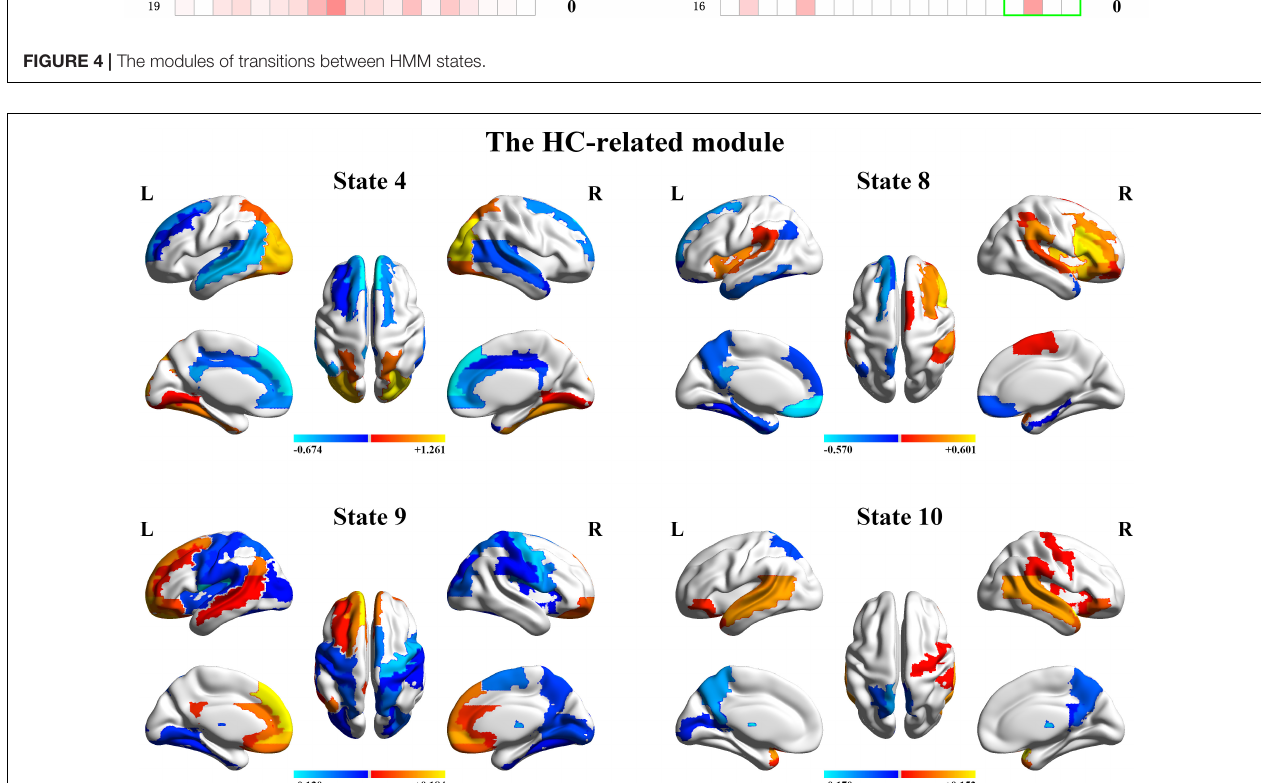
FIGURE 5 | The mean activation maps for states 4, 8, 9, and 10 in the healthy control (HC)-related module.